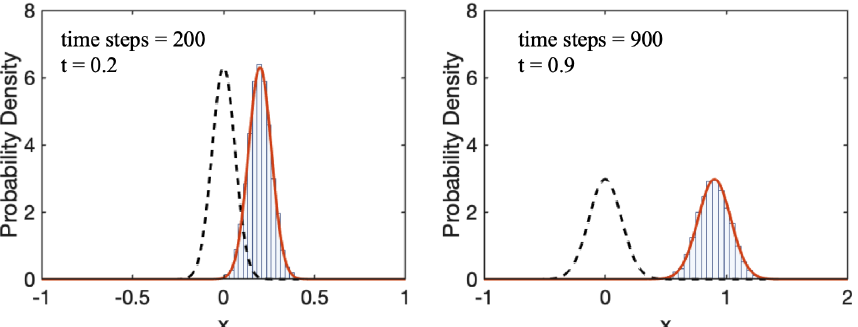
Figure 6. PDF for position of particles diffusing via one-dimensional Brownian motion plus drift. Histograms correspond to generalized Langevin equations (GLE) data and solid lines corresponds to FP solutions. For comparison, FP solutions without drift are shown in dashed lines. In this figure, D = 10 − 2 µ m 2 /s, u = 0.2 µ